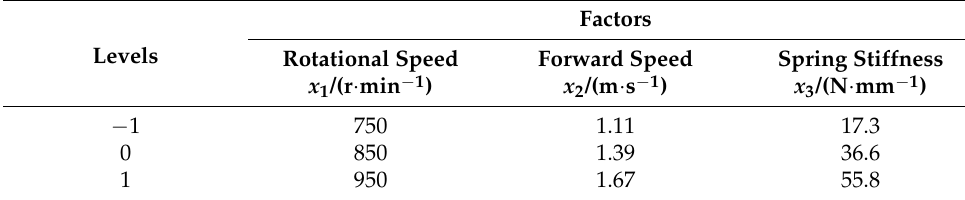
Table 3. Factors and levels of test.